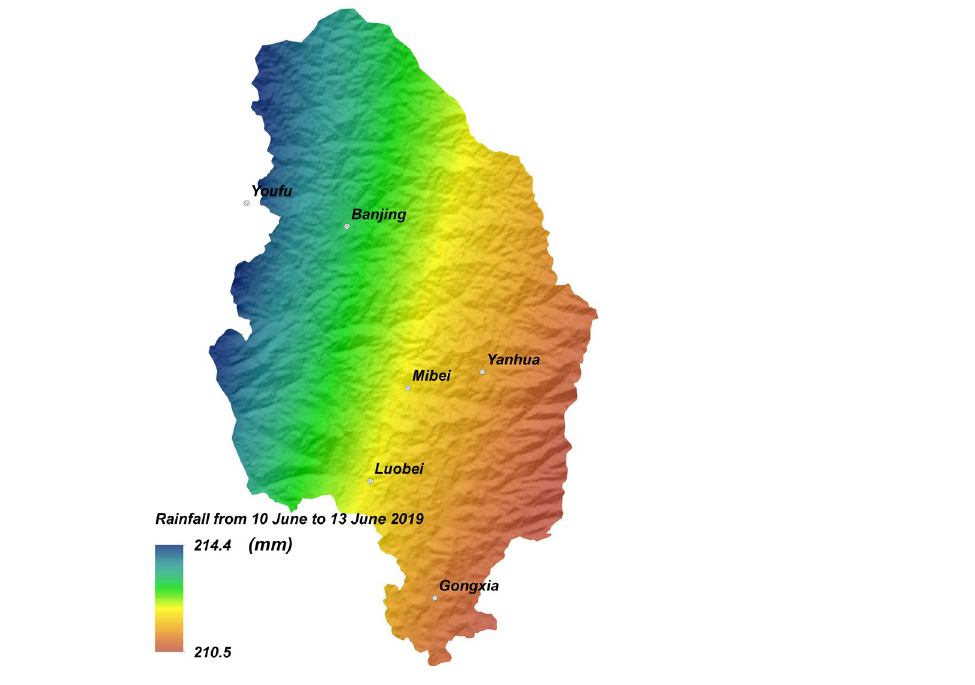
Figure 6. Mapping shows the spatial distribution of total rainfall from 10 June 2019 to 13 June 2019.